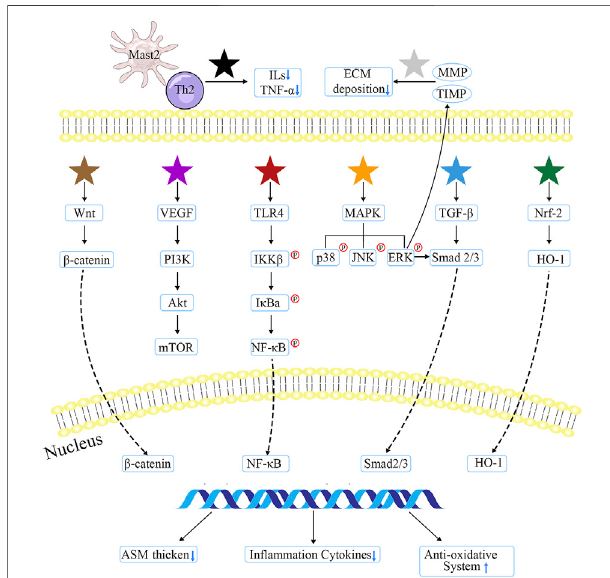
FIGURE 2 | The major targets and mechanisms of TCM involved in anti- airway in fl ammation and remodeling. Black star indicates Gu-Ben-Fang-Xiao decoction, Jia-Wei-Yu-Ping-Feng-San, ginsenoside Rg1/3, ligustrazine, bulleyaconitineA,andrographolide,andosthole;thegrayonerepresents Xiaochuanping powder, glycyrrhizic acid, and curcumin; brown star signi fi es curcumol; purple star means Yanghe Pingchuan granules, Soufeng Yuchuan decoction, Pingchunning Decoction, luteolin, and emodin; red star refers to Mahuang Decoction, Jin-Gui-Shen-Qi Wan, piperlongumine, evodiamine, baicalin, curcumin, chrysophanol, shikonin, and resveratrol; orange star denotes Bu-Shen-Yi-Qi fangm cordycepin, and icariin; blue star implies Mahuang Decoction, Fangxiao formula, and sinomenine; green star suggests tetrandrine, polydatin, and